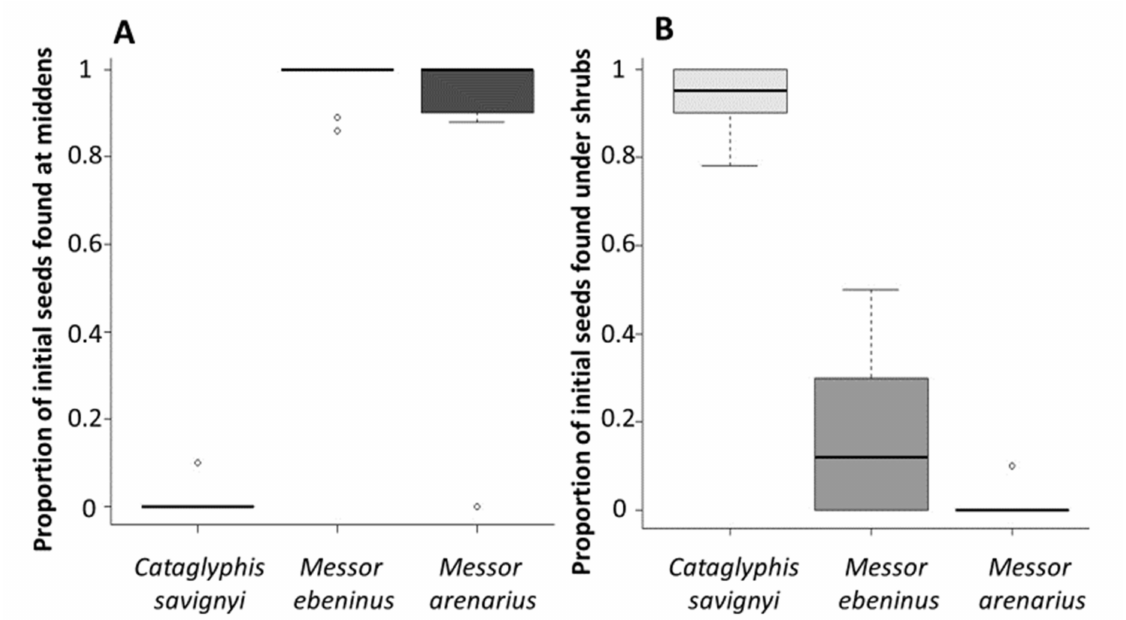
Figure 3. Habitats of final seed location following redispersal by each ant species: ( A ) Location relative to middens. ( B ) Location relative to shrubs. Each boxplot represents the median (black horizontal line), 25, and 75 quartiles. The error lines as described in Figure